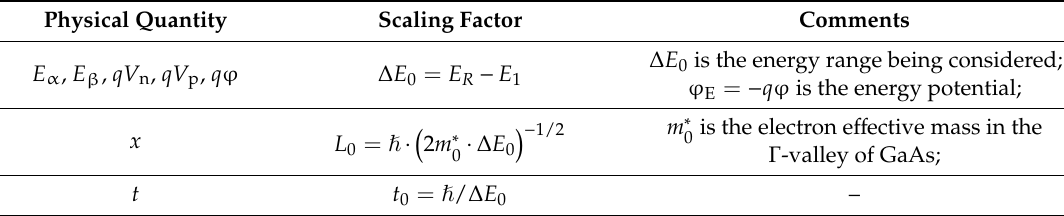
Table 1. The first system of scaling factors for Equations (1), (2), and (9).